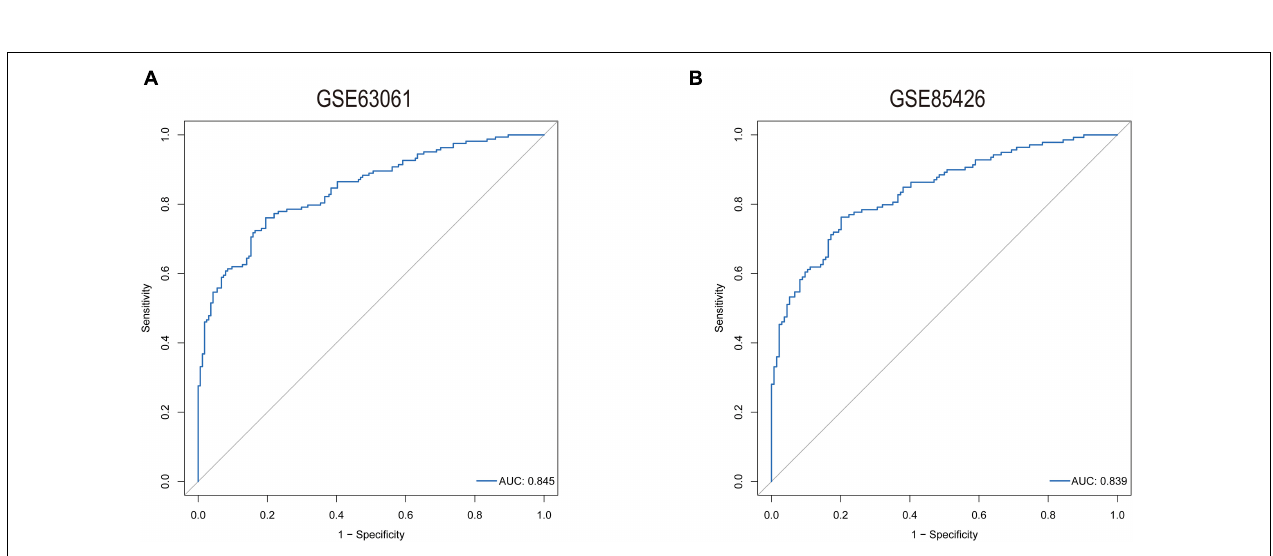
FIGURE 7 | ROC curves for evaluating the accuracy of logistic regression analysis of training set [ (A) , GSE63061] and validation [ (B) , GSE85426].